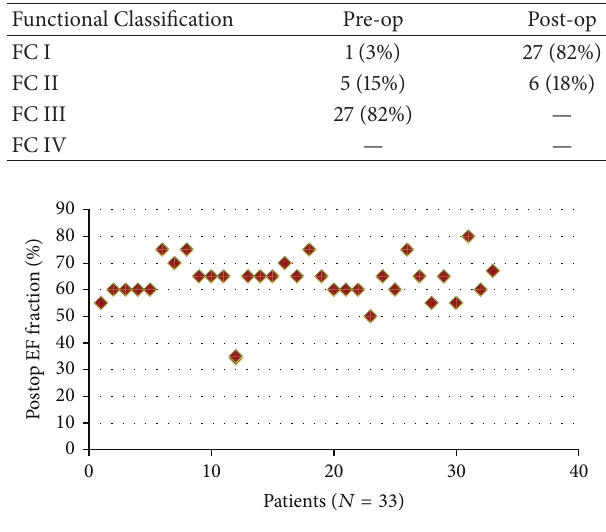
Figure 1: Left ventricular